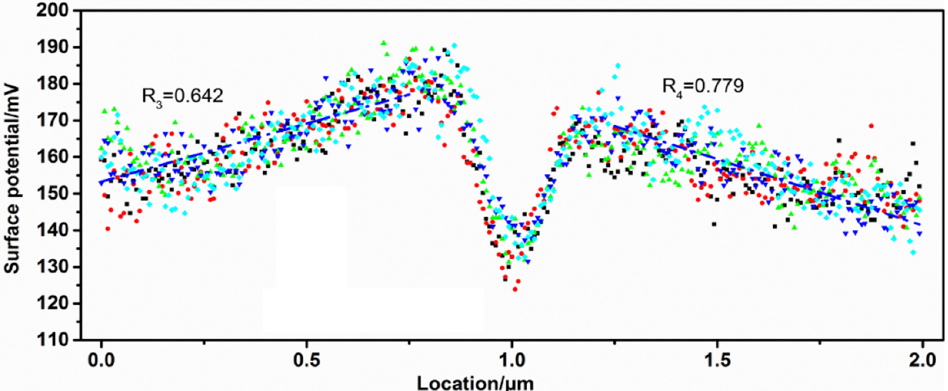
Figure 11. Cross-section of the surface potential in Figure 9(b 1 ).